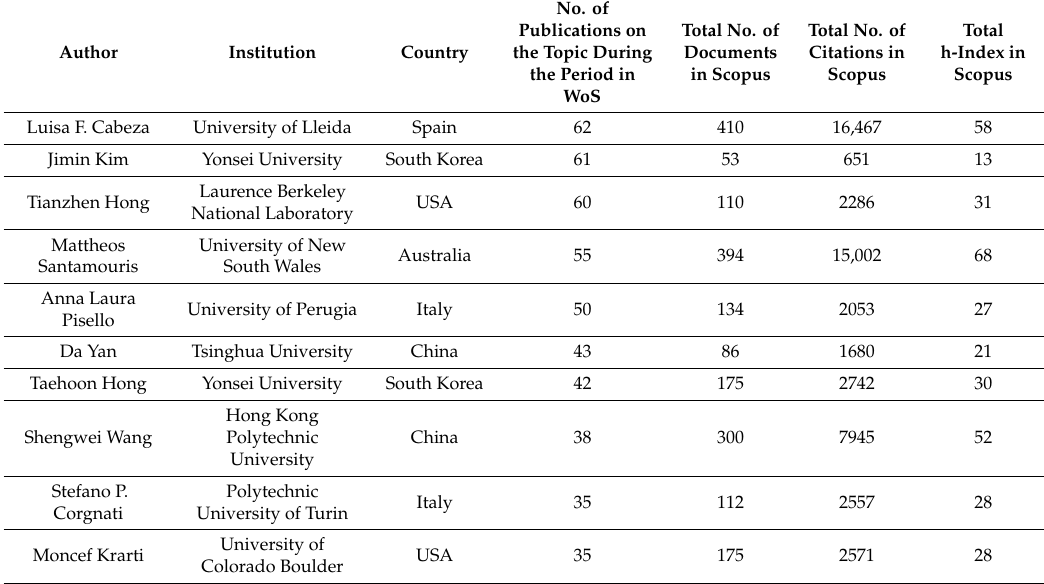
Table 1. Authors with the highest number of publications in the field of study between January 2013 and September 2019. WoS is Web of